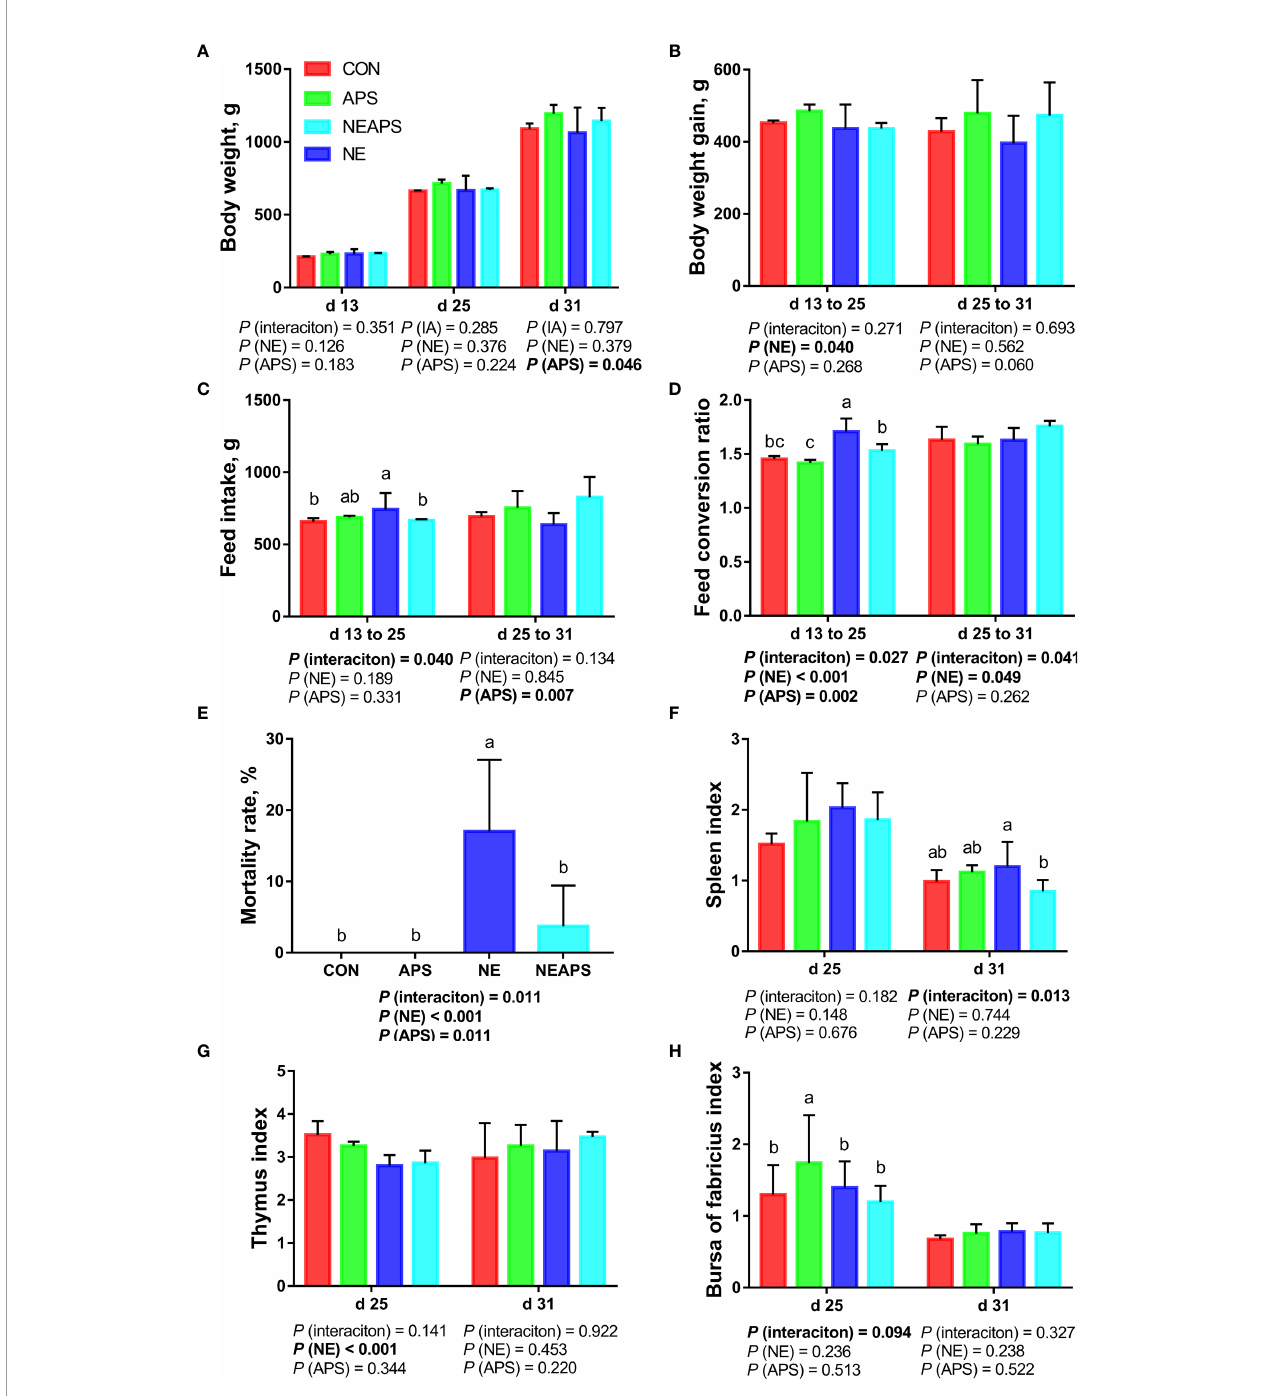
FIGURE 1 | Effects of dietary astragalus polysaccharides supplementation on growth performance, mortality rate and immune organ index of broiler chickens challenged with necrotic enteritis. The body weight (A) , body weight gain (B) , feed intake (C) and feed conversion ratio (D) were analyzed by weighted. The mortality rate (E) was calculated as the ratio of the number of broilers that died in each cage to the total number of broilers on d 13 to 31. The spleen index (F) , thymus index (G) and bursa of fabricius index (H) were analyzed by weighted. All graphs are presented as mean, with the standard deviation (SD) shown via the whiskers. The main effect and interaction effects were analyzed using the general linear model (GLM) procedure, with the P values for the main effects written out below each plot. The one-way ANOVA and multiple comparisons were performed when interactive effects differed signi fi cantly. The lowercase letters on the bar charts indicate signi fi cant differences ( P < 0.05). CON, control group; APS, APS group; NE, NE infection group; NEAPS, APS infected with NE